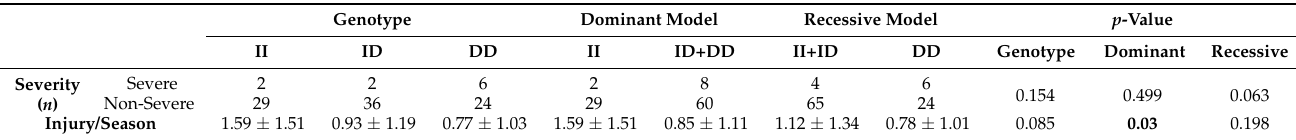
Table 4. Association between the ACE I/D genotypes and severity and incidence of non-contact muscle injury (per season). Genotype Dominant Model Recessive Model p -Value